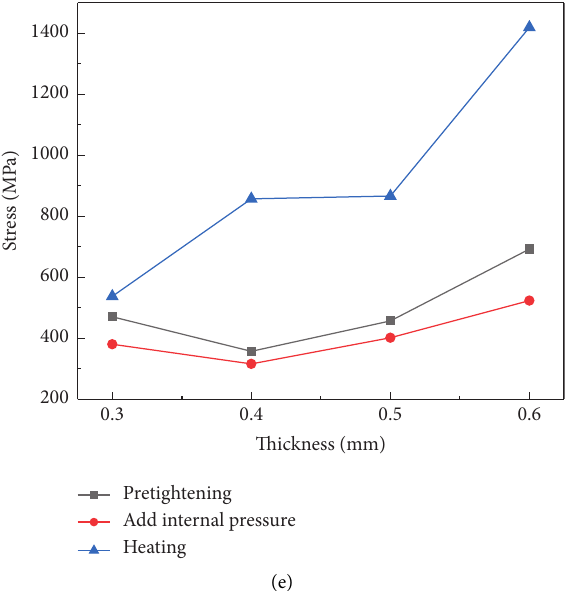
Figure 20: Contact pressure trends of various corrugations in different states in regard to sheet thickness. (a) Corrugation A. (b) Corrugation B. (c) Corrugation C. (d) Corrugation D. (e) Corrugation